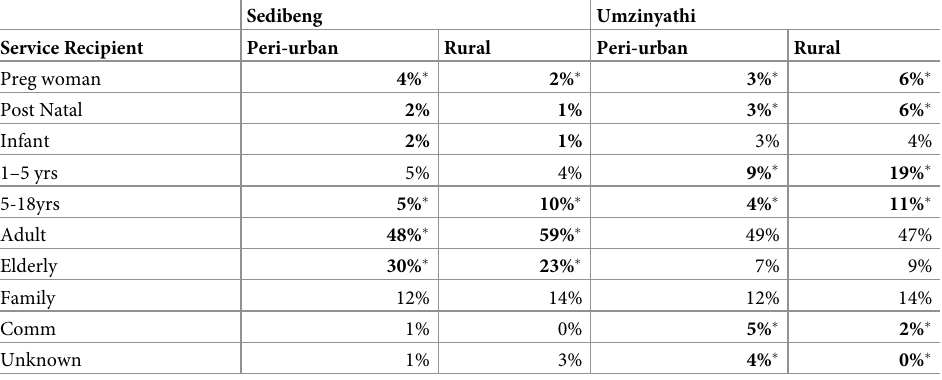
Table 4. Recipients seen during home